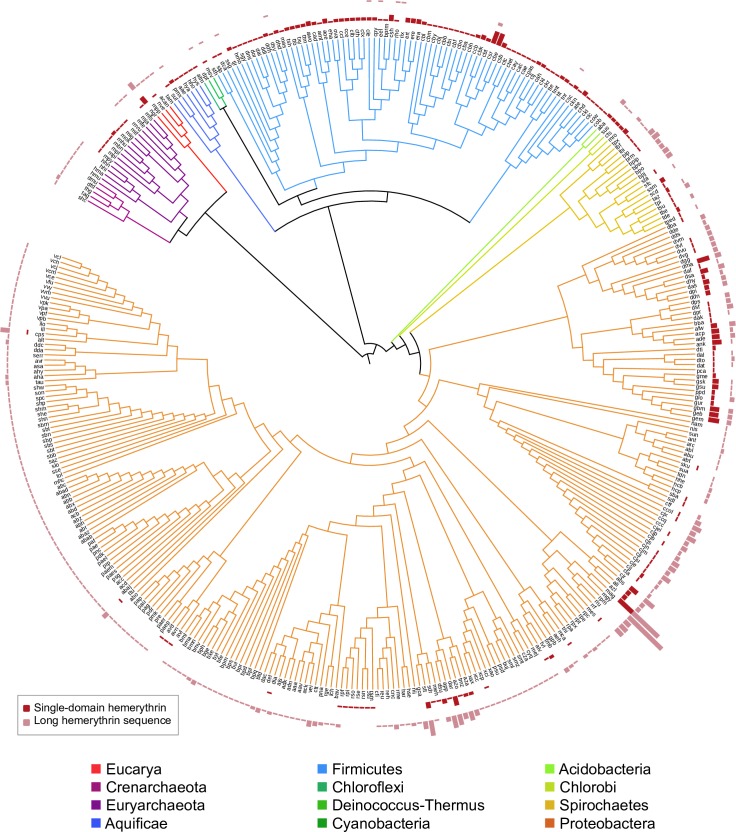
Phylogenetic tree based on species encoding for at least one hemerythrin protein domain.Phylogenetic tree based on a small subunit rRNA guide tree. Branch lengths are arbitrary. Each node corresponds to a completely sequenced species with at least one O2-binding Hr sequence homolog. Species names were replaced by their unique KEGG Organisms code [20]. The height of the bar charts is proportional to the absolute number of O2-binding Hr copies in each category: single domain O2-binding Hr sequences (red), long O2-binding Hr sequences (pink).